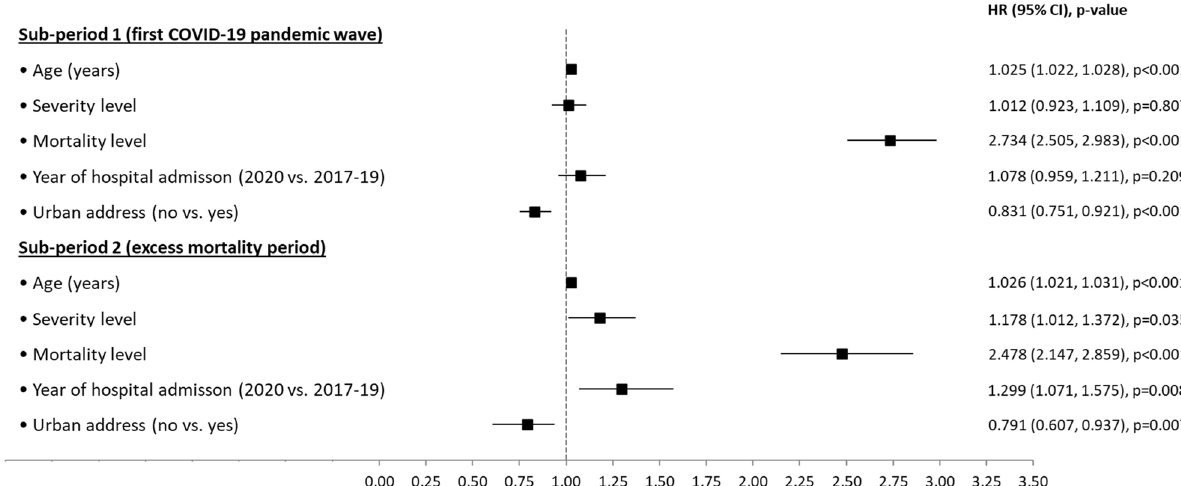
Figure 2. Impact of different variables on in-hospital mortality in patients without COVID-19 admitted to the Virgen del Rocío University Hospital. Multivariable Cox analysis with adjusted hazard ratios for the sub- period 1 (February 27 to June 7, 2020) and the sub-period 2 (March 17 to April 20, 2020). HR, hazard ratio; CI, confidence